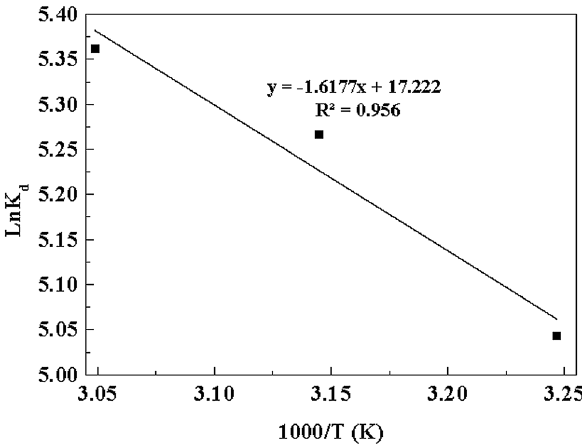
Figure 11. Thermodynamic parameter for MB adsorption onto Cu(OH) 2 -NWs-PVA-AC Nano-composite. Conditions: As shown in Fig. 10.